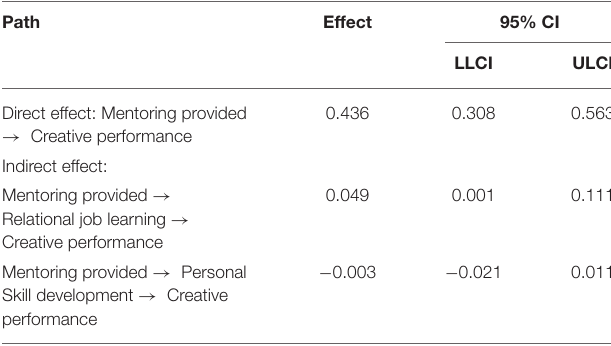
TABLE 5 | Direct and indirect